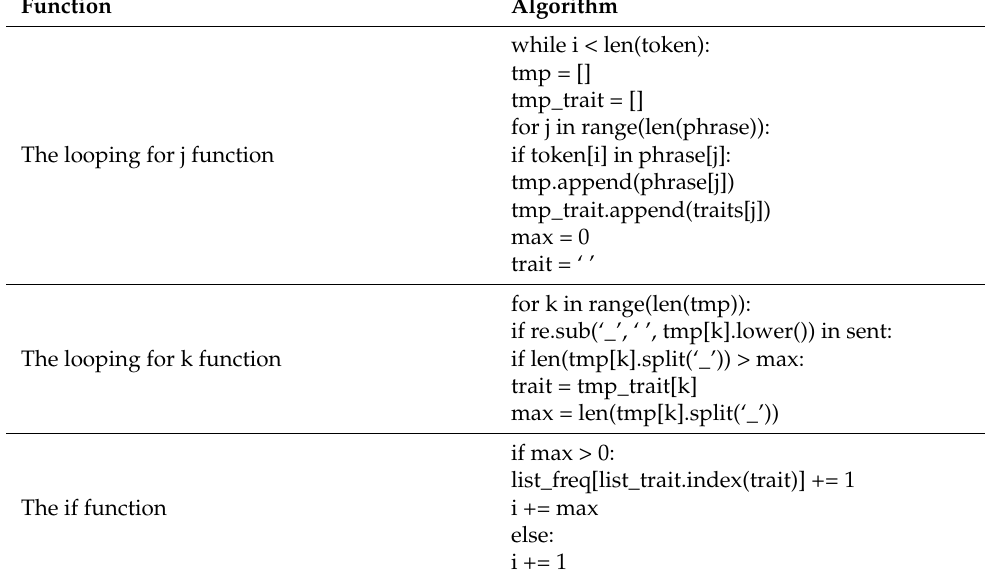
Table 4. The n-gram parsing algorithm.